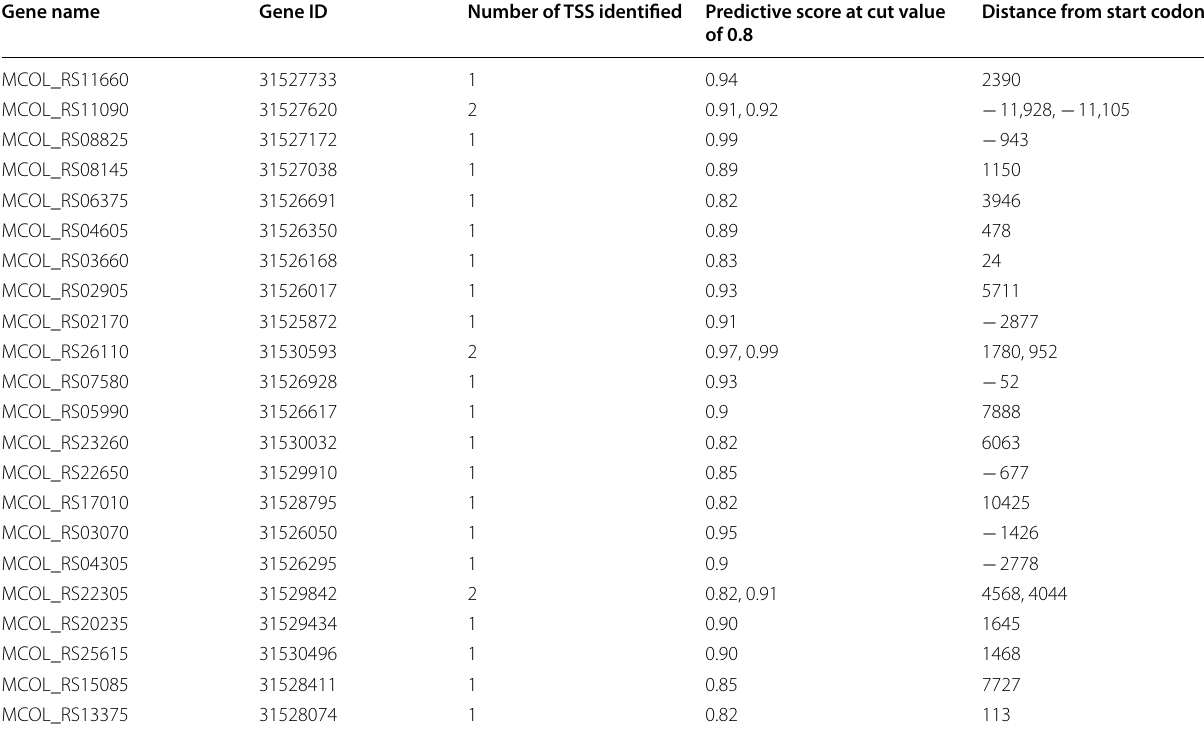
Table 1 Identified TSSs, predictive score value, and their distances from start codon Gene name Gene ID Number of TSS identified Predictive score at cut value